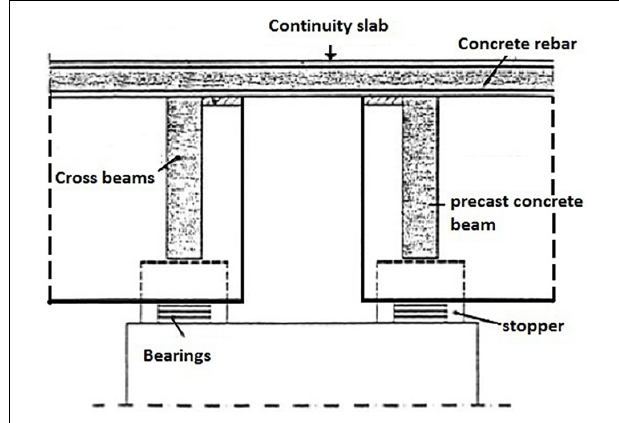
FIGURE 5 | Typical arrangement for the continuity slab at the pier head (adapted from Greek Ministry guidelines).